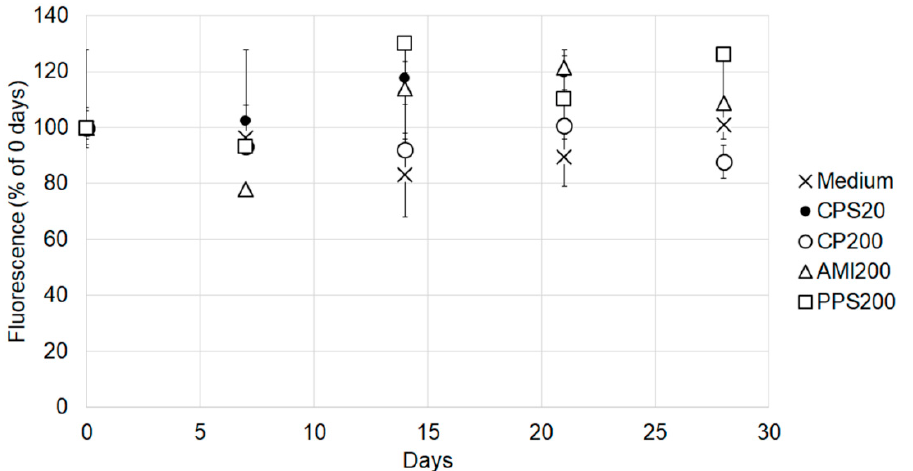
Figure 3. Fluorescence of particle suspensions stored in the cell incubator for up to 28 d compared